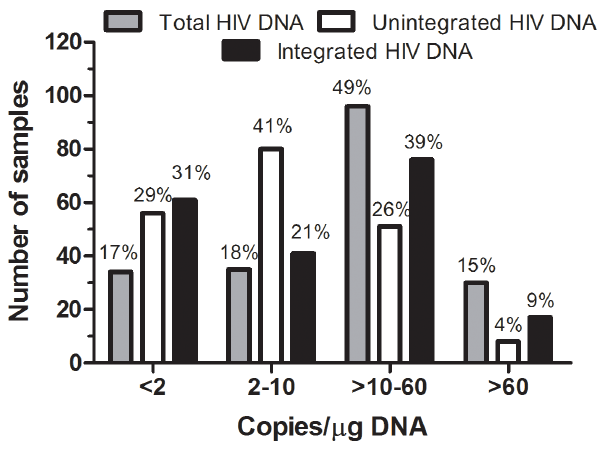
Figure 3. Distribution of total, unintegrated and integrated HIV DNA copy number in four range: very low ( , 2 copies), low (2– 10), medium ( . 10–60) and high ( , 60) for 195 blood samples.